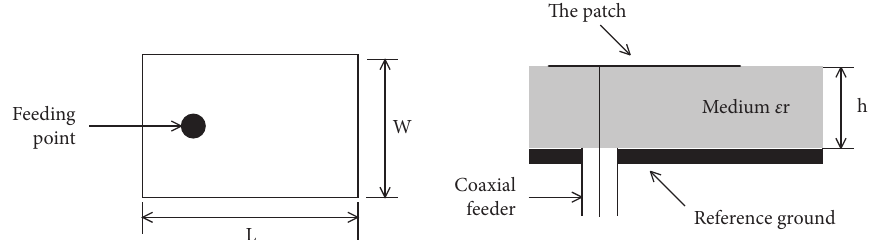
Figure 4: Schematic diagram of rectangular